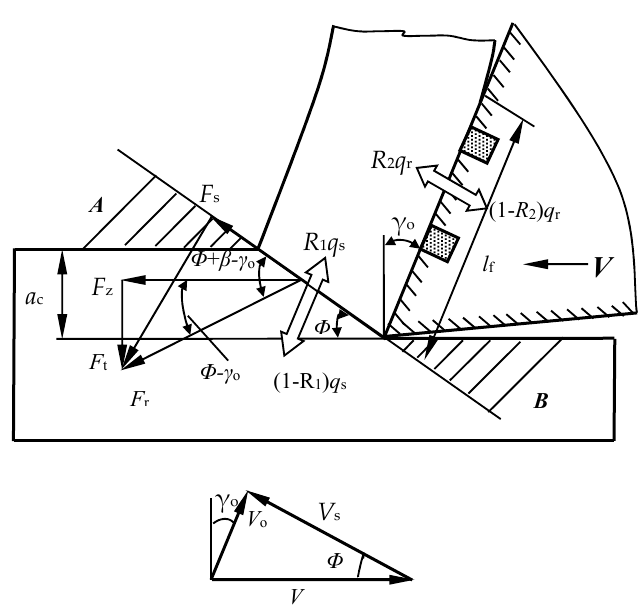
Figure 18. Schematic diagram of the heat distribution during cutting process.